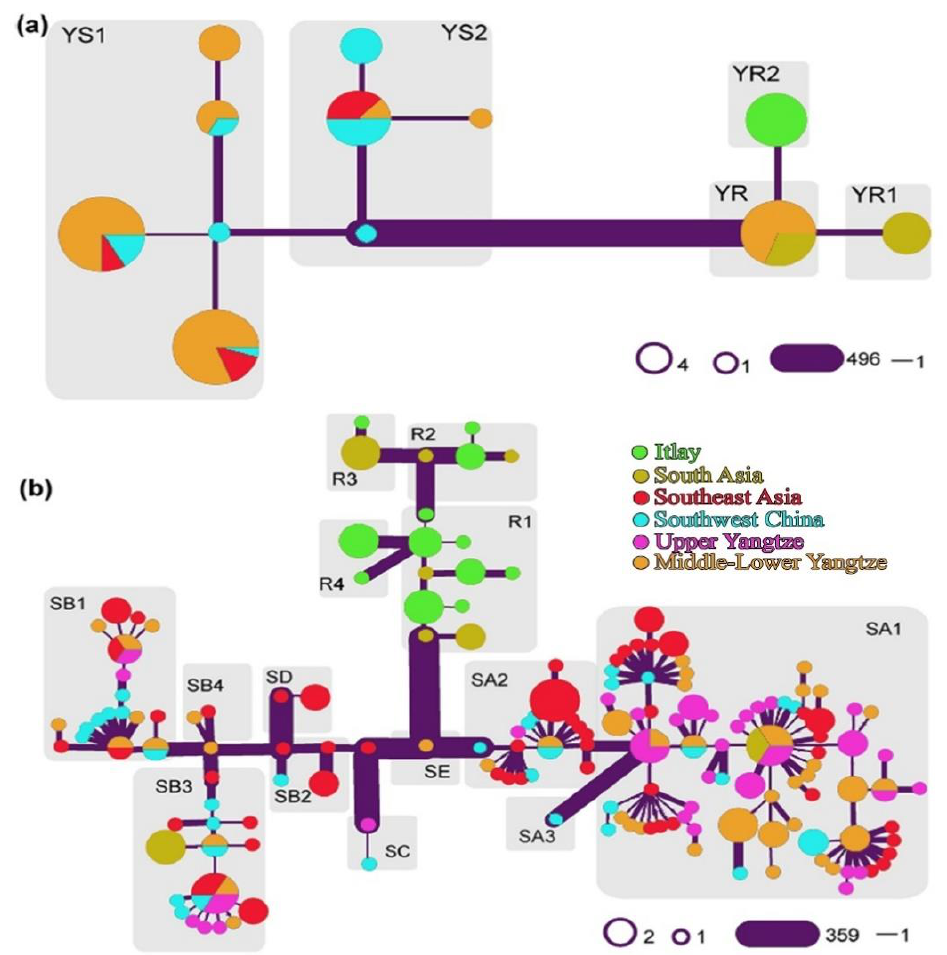
Figure 4. Phylogenies based on mitogenome and Y-chromosome. The pairwise differences between the adjoining haplotypes are represented by the widths of the edges. ( a ) The network of Y-chromosome using 520 SNPs. ( b ) Swamp buffalo mitogenome network. Diverse haplogroups of mitogenomes and Y-chromosomes are characterized in each gray box [47] (figure reproduced by Rehman et al., 2021, with the permission of authors).